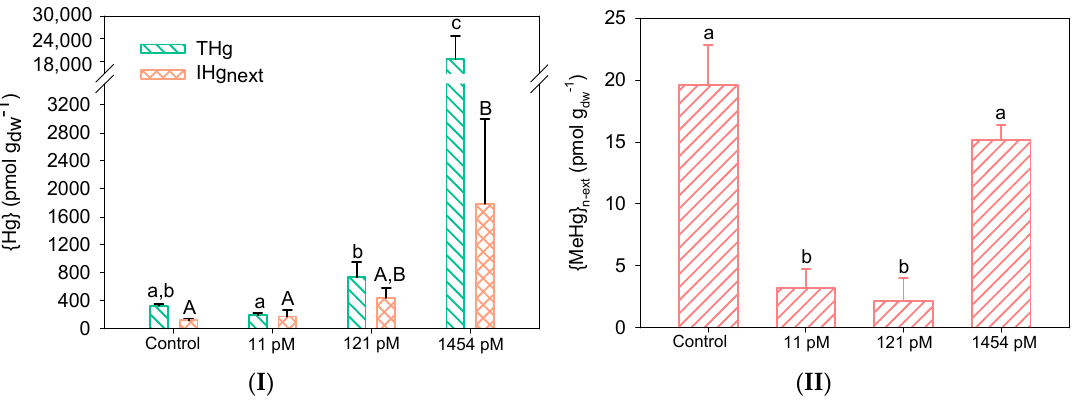
Figure 1. Concentrations of ( I ) total Hg and non-extractable IHg ( n = 3), and ( II ) non-extractable MeHg ( n = 3) as a function of the measured dissolved Hg concentrations. Letters (a, b, c and A, B) indicate significant differences between treatments for the studied characteristics ( p < 0.05).